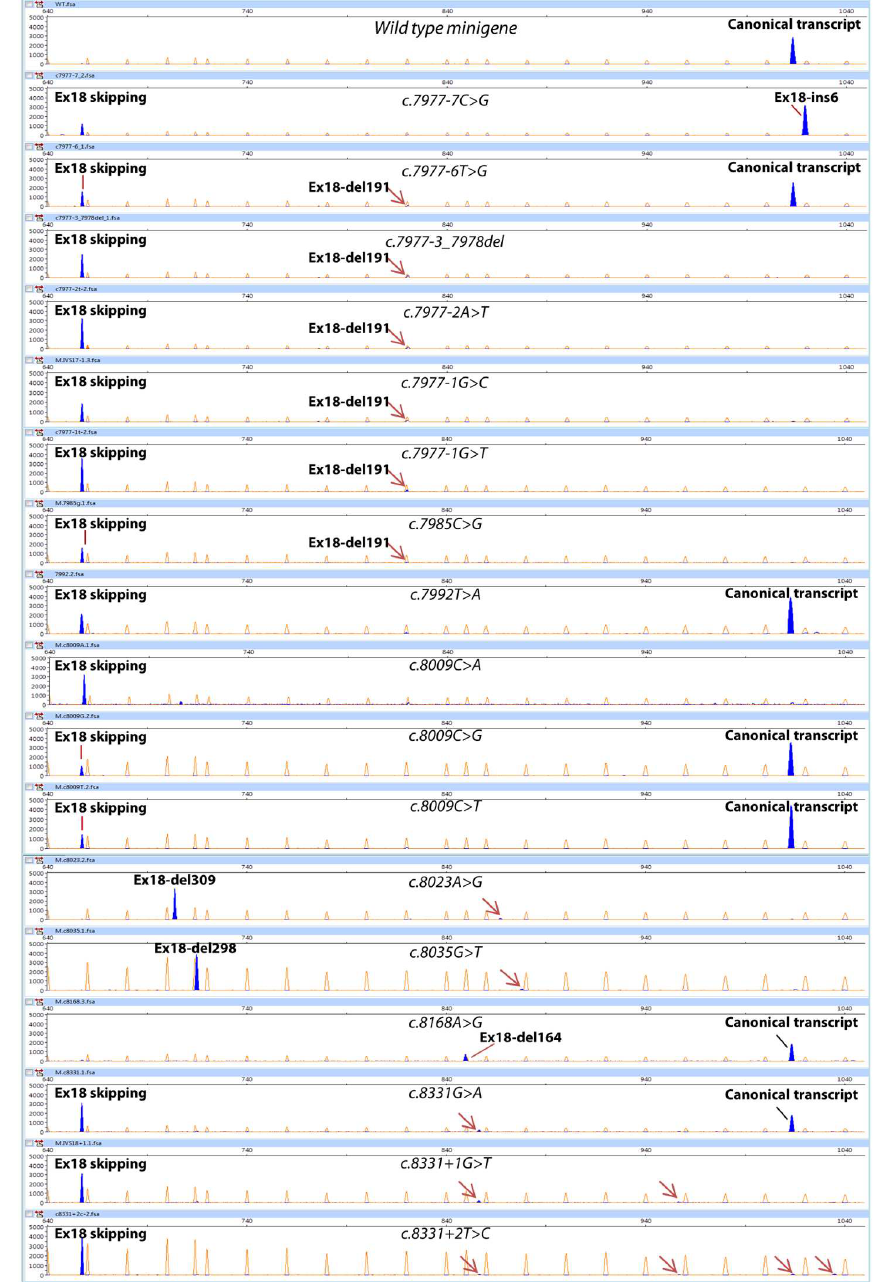
Fig 4. Analysis of transcripts induced by DNA variants from exon 18. cDNA was amplifiedwith primers RTBR2_ex16-FW ( BRCA2 exon 16) (blue peaks) and FAM-labelled RTpSAD-RV (exon V2 of minigene)and electrophoresedon a DNA sequencerwith Genescan LIZ 1200 as size standard (orange/faint peaks). Arrows indicateminor aberranttranscripts. Screenshots of electropherograms visualizedwith the Peak Scanner software v1.0 are shown. Fragment sizes (bp) and relative fluorescent units are indicatedon the x- and y- axes, respectively. Electropherograms of c.8007A > G, c.8072C > Tand c.8249_8250delare not represented since they show similar patterns (partial exon 18 skipping)to other DNA variants (e.g. c.8009C > G).